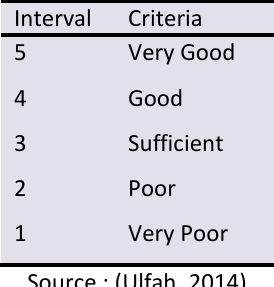
Table 1. Likert Scale of Validity Sheet